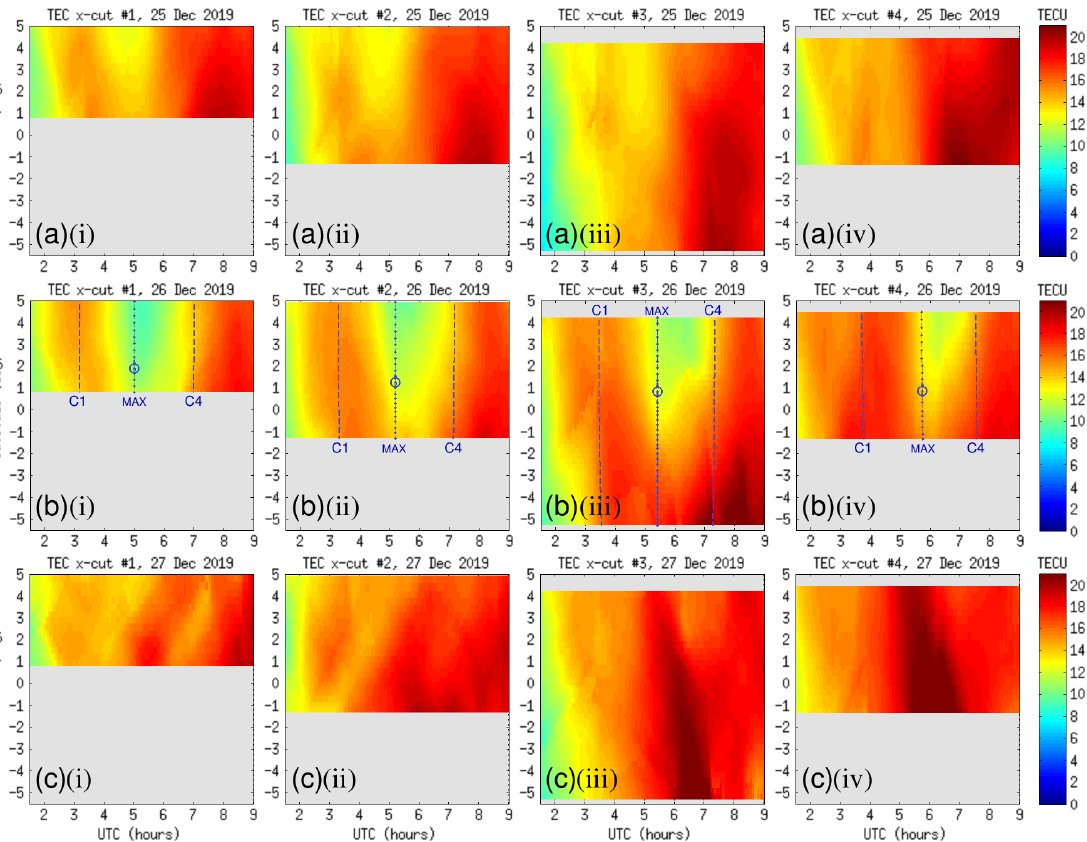
Figure 13. Color-map plots of GPS TEC values as a function of time and latitude along x-cut nos. 1 to 4 on (a) 25, (b) 26, and (c) 27 December 2019. Time intervals are magnified around the solar eclipse on 26 December 2019. The start and end times of the eclipse (C1 and C4) as well as the moment of maximum eclipse are indicated by dashed and dotted curves on the plots. Circles indicate the moment and location of the greatest solar obscuration along each